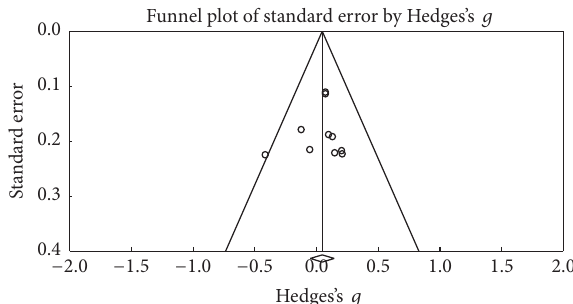
Figure 8: Funnel plot for standard error in publications of Trail Making Test (TMT-B).